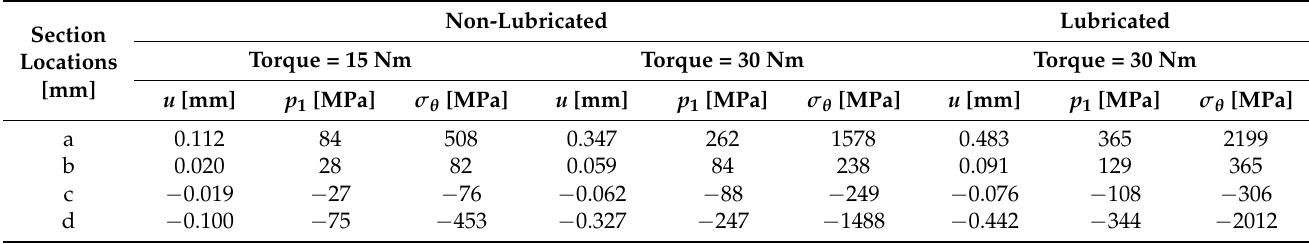
Table 2. Displacement, internal pressure, and hoop stress of inner ring, for Test 1a.